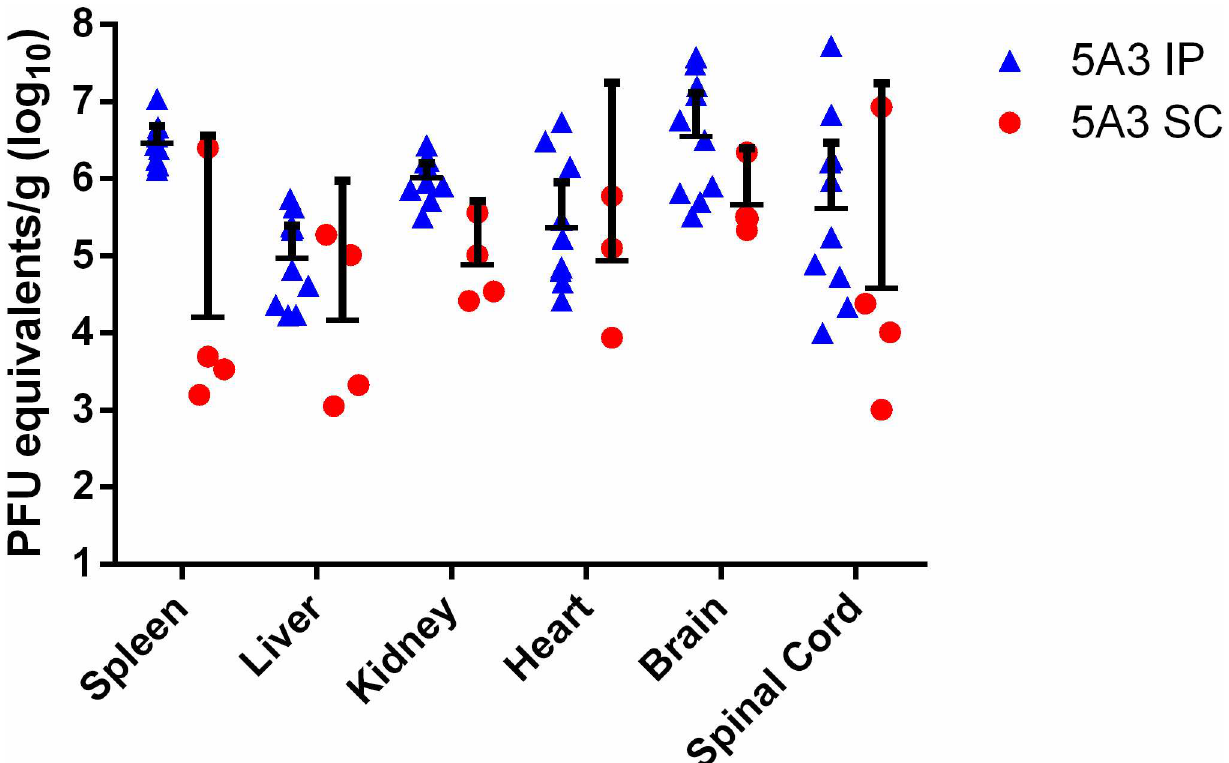
Fig 2. Viral titers of ZIKV in Wild-type Mice Treated with an IFNAR1-Blocking MAb. Five week old wild-typemice were treated with an IFNAR1-blocking MAb or PBS by intraperitoneal (IP) injectionand then exposedto 6 log 10 of ZIKV strain DAK AR D 41525subcutaneously (SC) or IP. When mice succumbed or were euthanized, tissues were collected,weighed,homogenized, and analyzedby qRT-PCR. Data are shown as PFU equivalents(PFUe) per gram (g) after normalization to a standardcurve. Symbolsrepresent the individual mice, the line represents the geometric mean, and the error bars represent the 95%